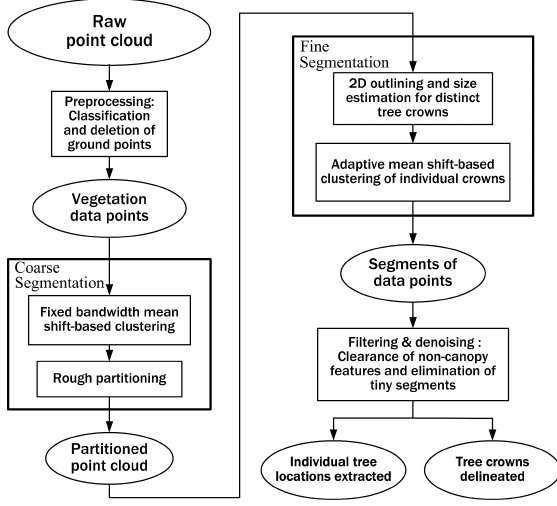
Figure 2. Flowchart of methods used in this